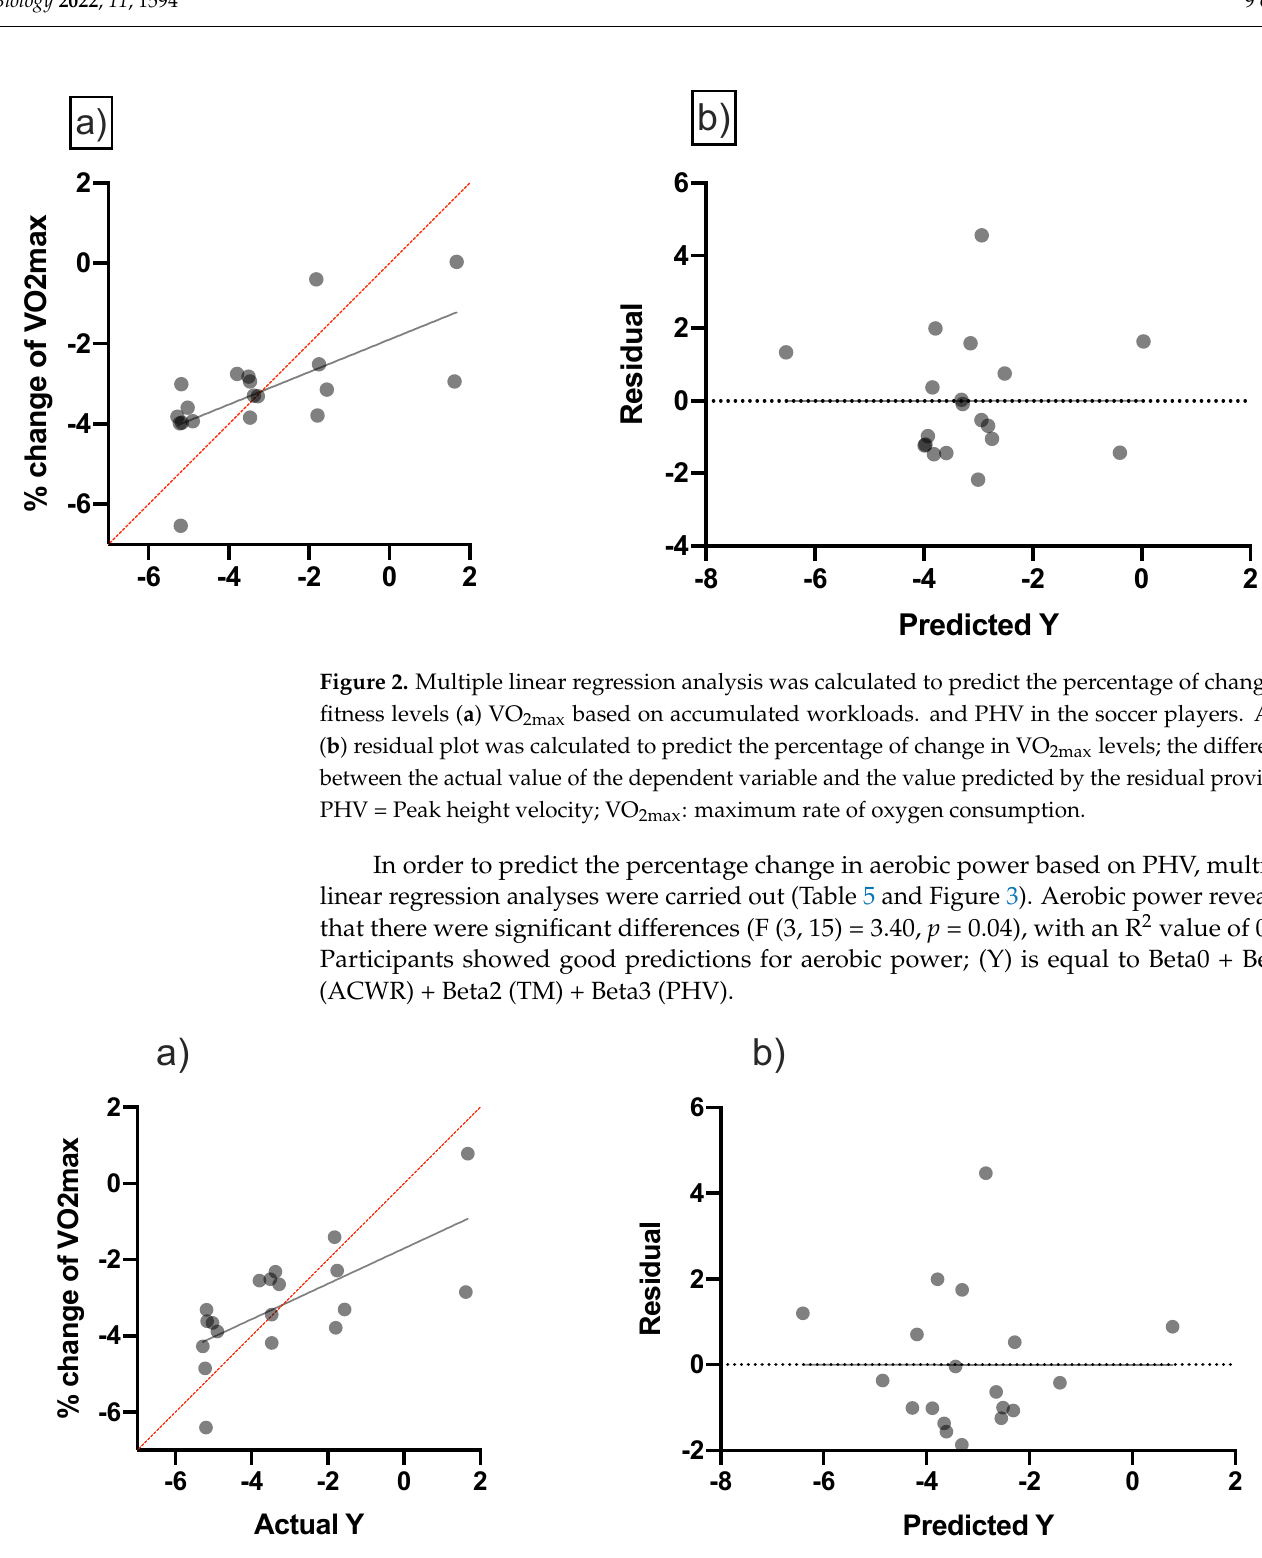
Figure 3. Multiple linear regression analysis was calculated to predict the percentage of change in fitness levels ( a ) VO 2max based on accumulated workloads and maturity offset in the soccer players. Also, ( b ) residual plot was calculated to predict the percentage of change in VO 2max levels; the difference between the actual value of the dependent variable and the value predicted by the residual provided. VO 2max : maximum rate of oxygen